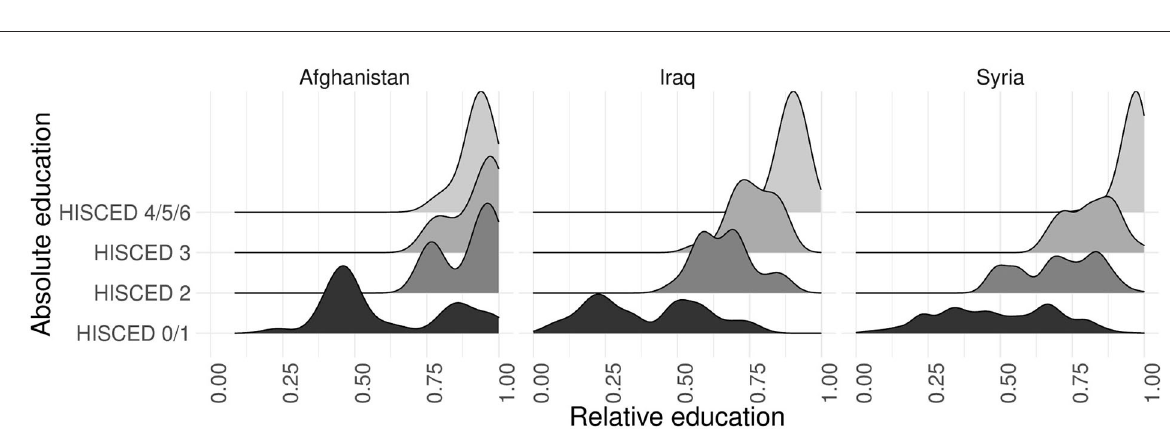
FIGURE2 Density distributions of the highest relative education in the household by HISCED level and origin group (Afghanistan: n = 89; Iraq: n = 167; Syria: n = 1,157). Because of the few cases from Iran ( n = 24), density distributions are not displayed for this origin group. Source: ReGES parent and adolescent data (wave